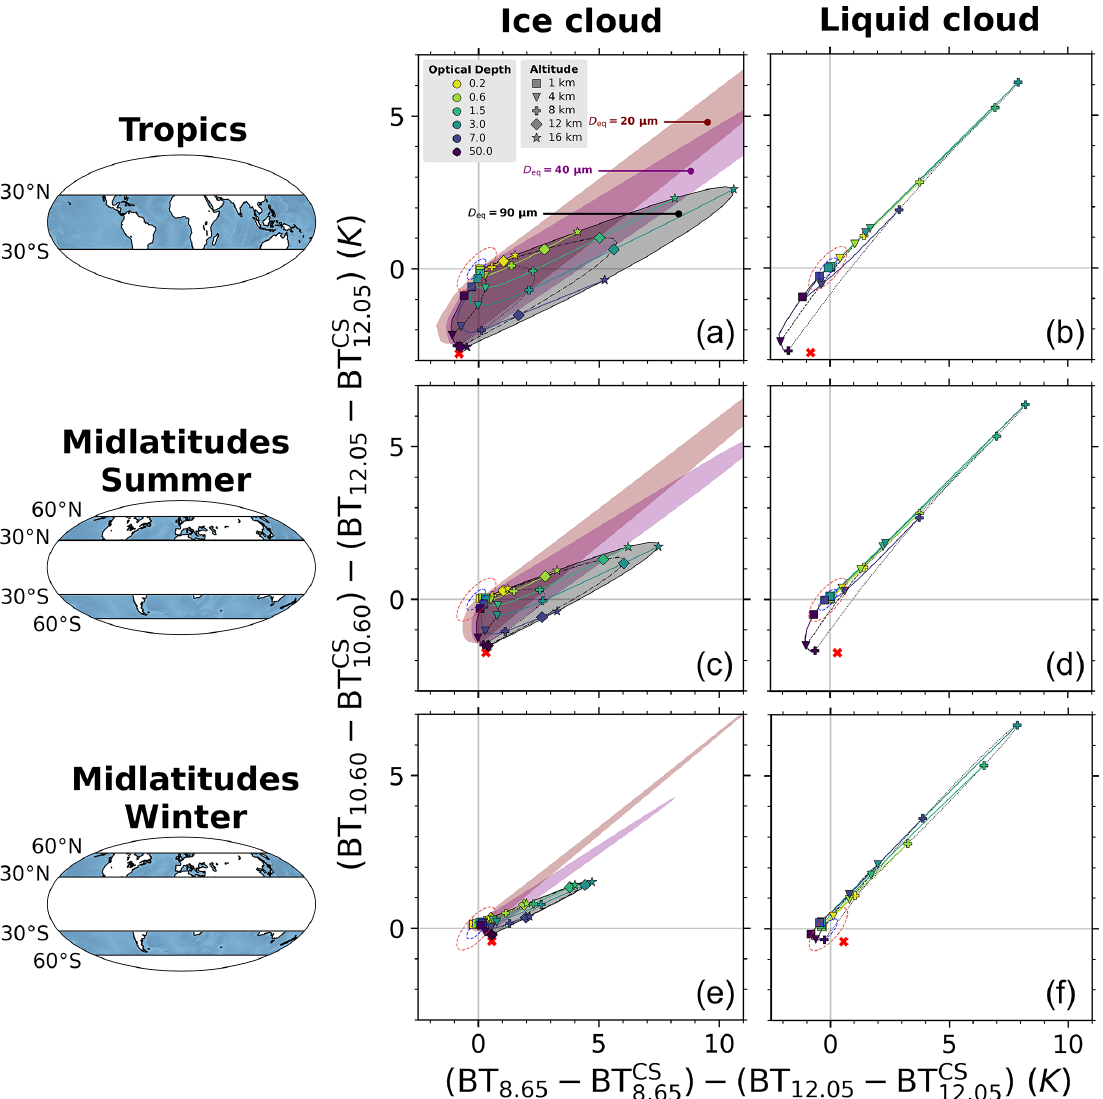
Figure 3. Radiative transfer simulations of the evolution of IIR signature (Sect. 3) with altitude and optical depth of an ice cloud (a, c, e) and a liquid cloud (b, d, f) with 1km geometrical thickness in a tropical atmosphere (a, b) , a midlatitude summer atmosphere (c, d) , and a midlatitude winter atmosphere (e, f) . The ice cloud particle size distribution is a general habit-mixed particle distribution (Baum et al., 2011) with an effective diameter D eq = 90µm. The liquid cloud particle size distribution is typical of a stratus cloud (Stephens, 1979). Surface and atmospheric profile properties for both the tropics and midlatitudes are from the standard atmospheres of McClatchey (1972). Cloud visible (550nm) optical depth (color) and top cloud altitude (marker shape) variations draw arches. Locations of those arches for ice clouds with D eq = 20µm and D eq = 40µm are shown in maroon and purple. The red cross shows the IIR signature of a top-of-atmosphere blackbody: − BT CS − BT CS BT CS vs. BT CS . The dashed red and blue ellipses represent the observed 95% and 50% confidence intervals of IIR 12 . 05 10 . 60 12 . 05 8 . 65 signature clear-sky observations (see Fig.